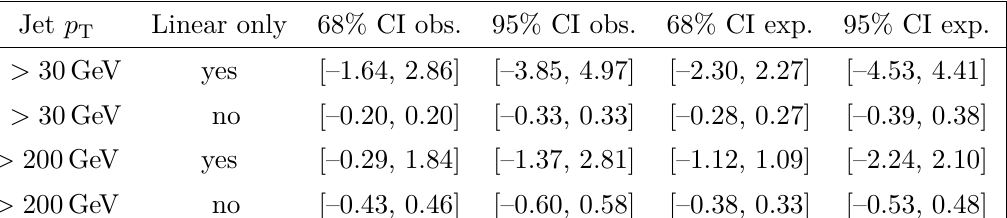
Table 8 . Observed and expected confidence intervals (CI) for c W for a linearized and a quadratic EFT fit of m , when requiring either jet p eµ Λ is set to 1